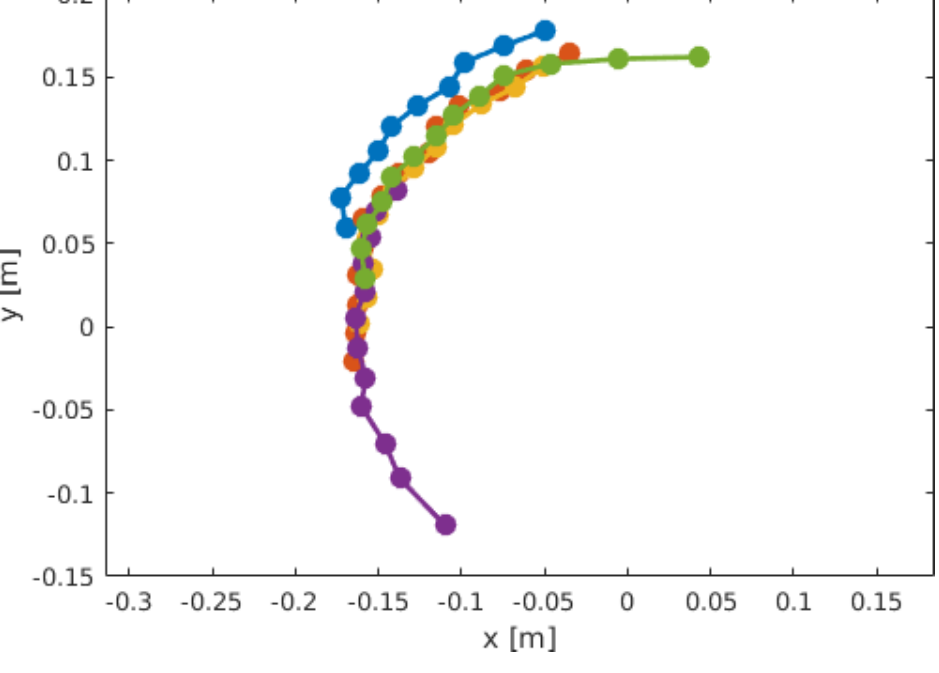
Figure 11. Overlapping point clusters from different scan lines gives a larger part of the stems circumference to which to fit a